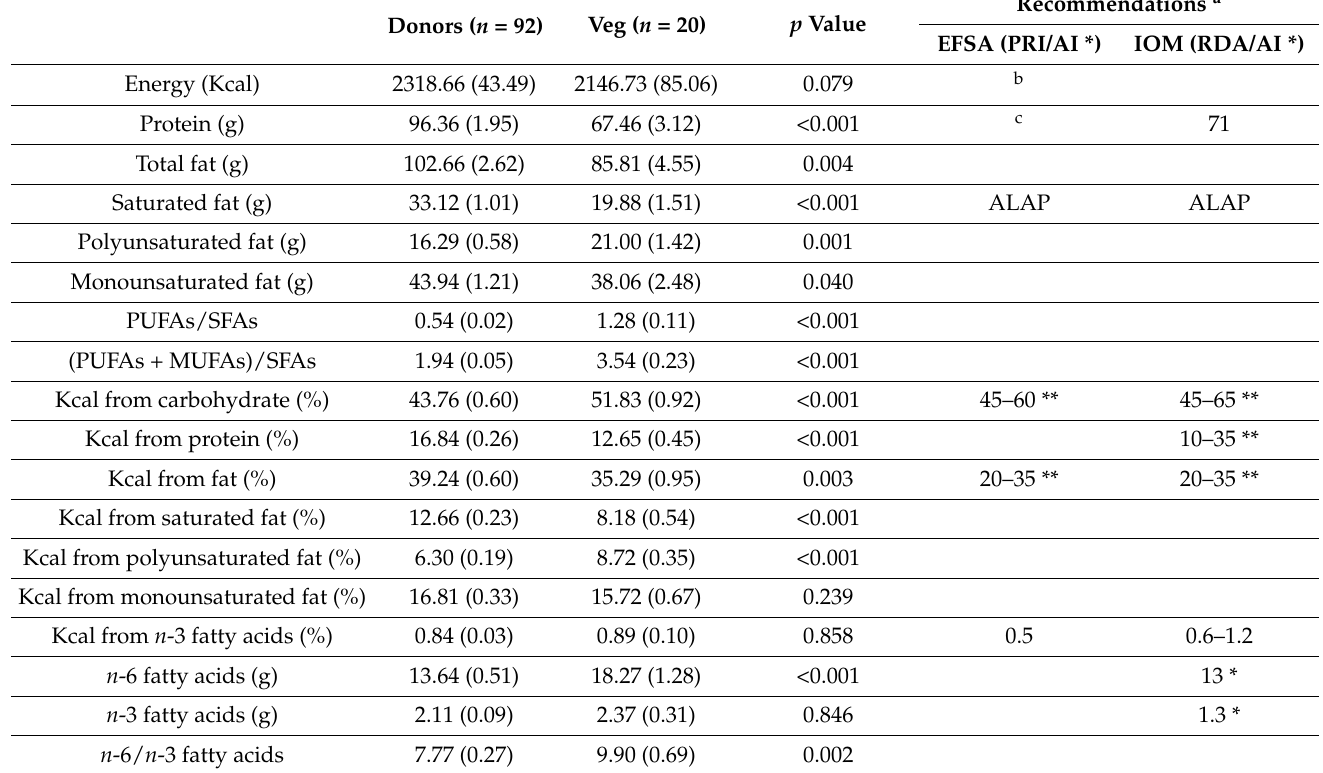
Table 5. Diet survey: five-day dietary record. Daily nutrients intake of the omnivore human milk donors with full-term infants (Donors) and vegetarian/vegan lactating mothers (Veg), compared with recommended daily